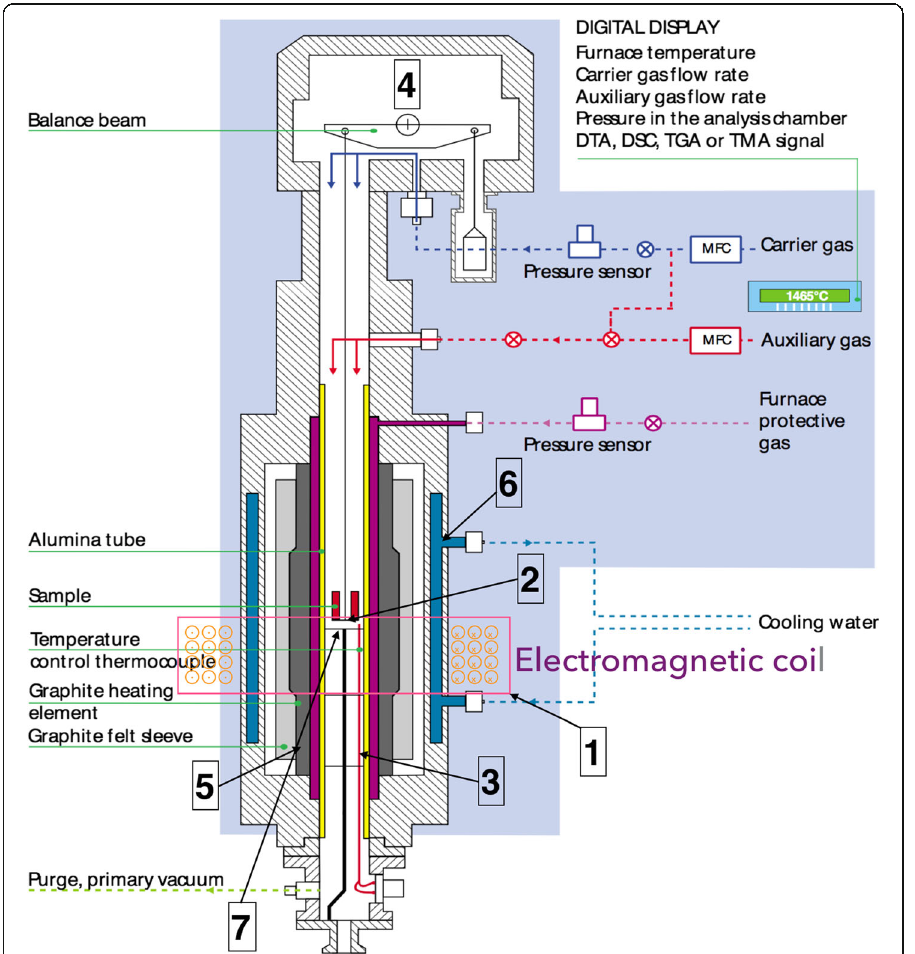
Fig. 1 Modified schematic of Setsys DSC-TGA: 1 Electromagnetic Coil, 2 Platinum Pan, 3 Control Thermocouple, 4 Microbalance, 5 Heater, 6 Water Cooling, and 7 Heat Shield [15] (used with